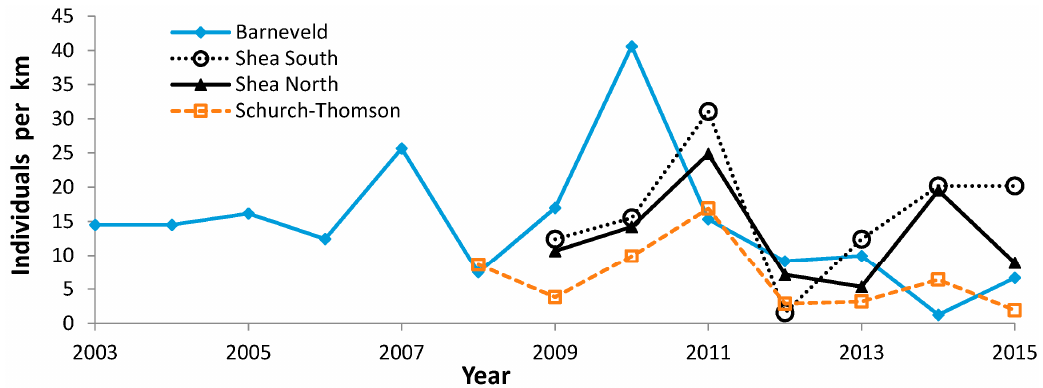
Figure 4. Regal fritillary individuals per km on peak survey per year at Barneveld, Shea (North, South), and Schurch-Thomson in Iowa County.